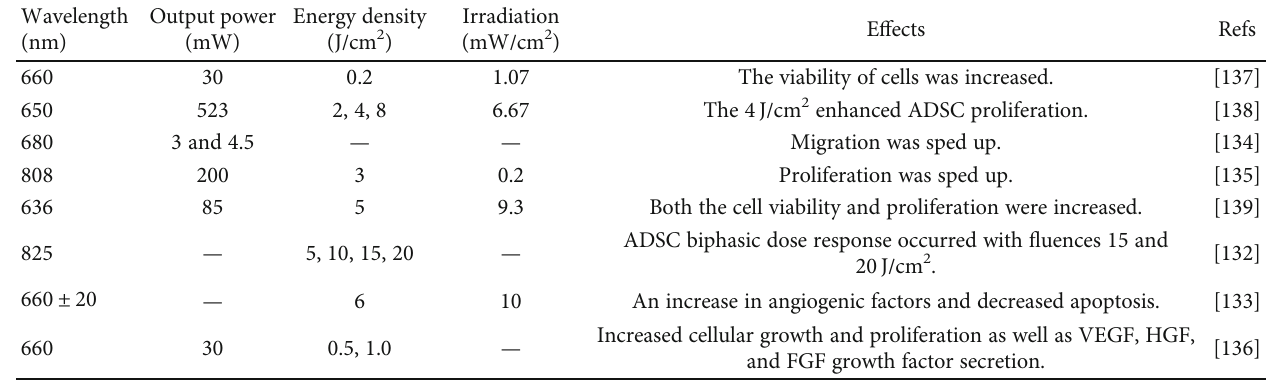
Table 3: E ff ects of PBM on